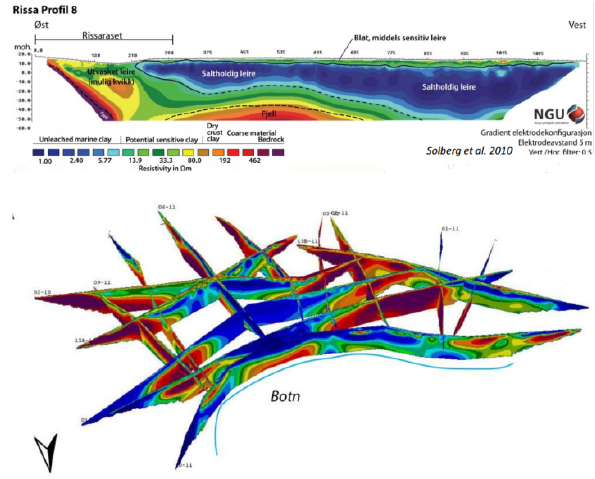
Figure 9: Intersecting profiles is very useful and give information on 3D geology. Example shows Rissa (Sør- Trøndelag, Norway): 17 profiles compose a network (~ 1 km2) of 2D resistivity data in an area with known stability challenges (Solberg).